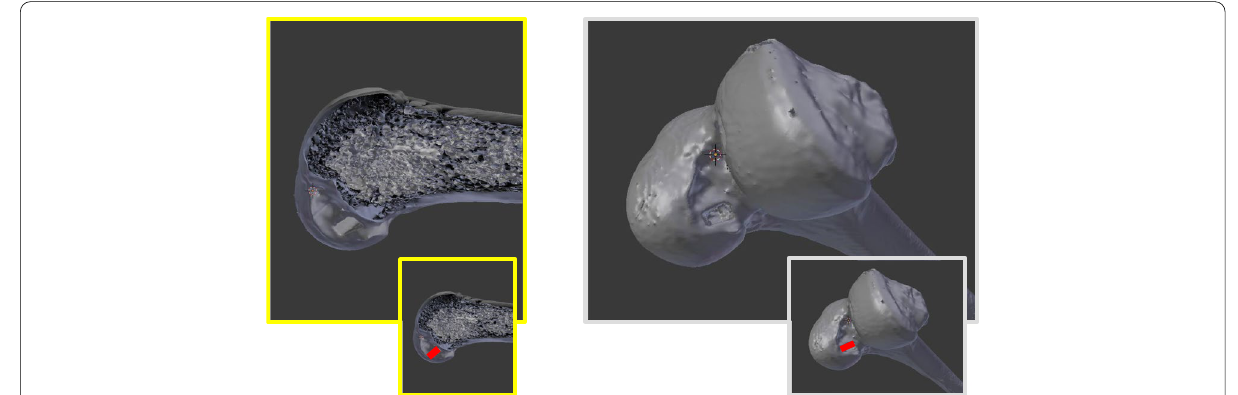
Fig. 5 CT scans with three-dimensional image reconstructions of the femoral tunnel performed with a specific